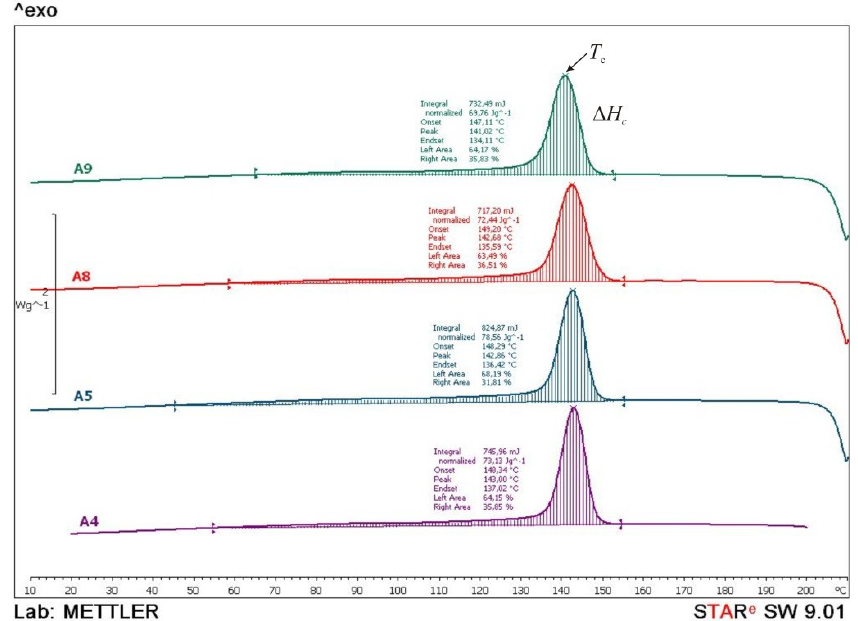
Figure 16. Comparative DSC thermograms of A4, A5, A8 and A9 samples obtained during the cooling cycle.